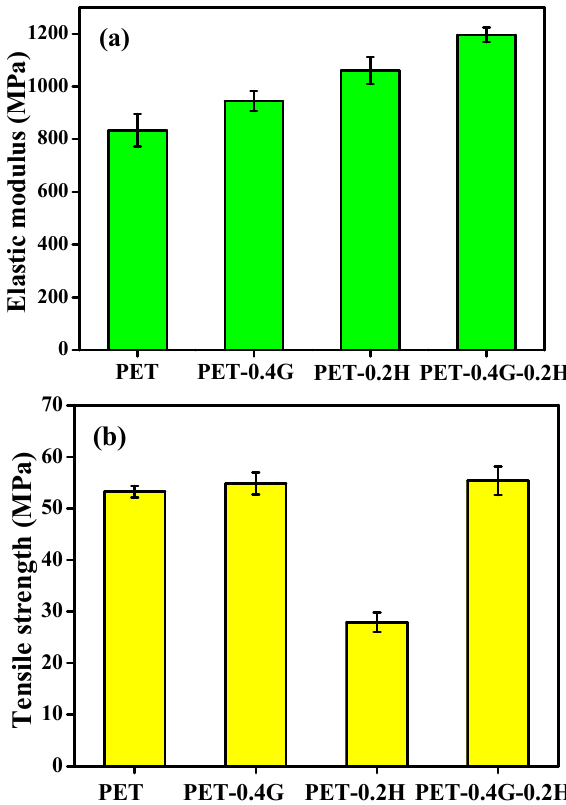
Figure 6. Mechanical properties of sample: ( a ) Elastic modulus, ( b ) Tensile